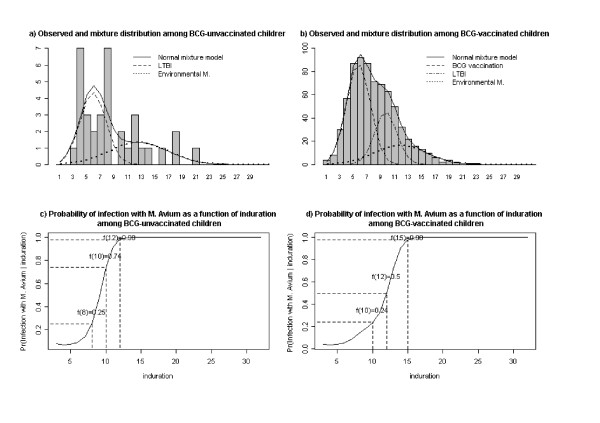
Induration distribution after sensitin test and probability of M avium infection as a function of induration diameter (mm) among unvaccinated children (on the left) and BCG-vaccinated children (on the right).